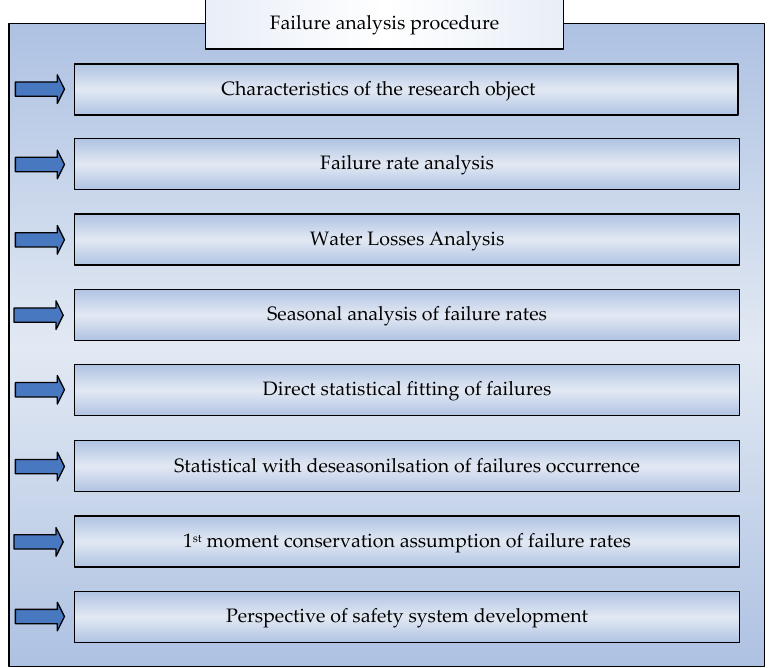
Figure 1. The failure analysis framework of the performed research.